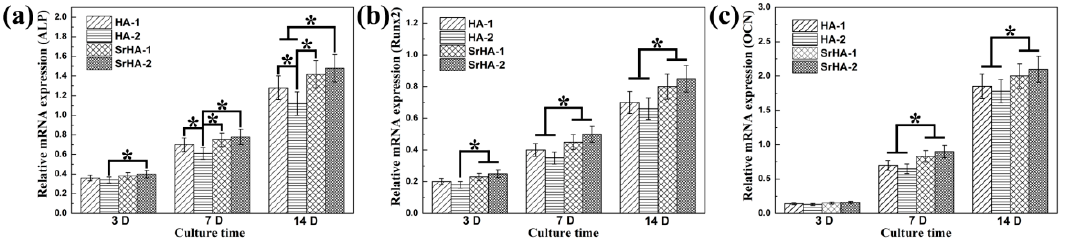
Figure 9. Gene expressions of MG63 cells cultured on different samples after incubation for three, seven, or 14 days: ( a ) ALP; ( b ) Runx2; ( c ) OCN. Statistically significant differences (* p < 0.05).